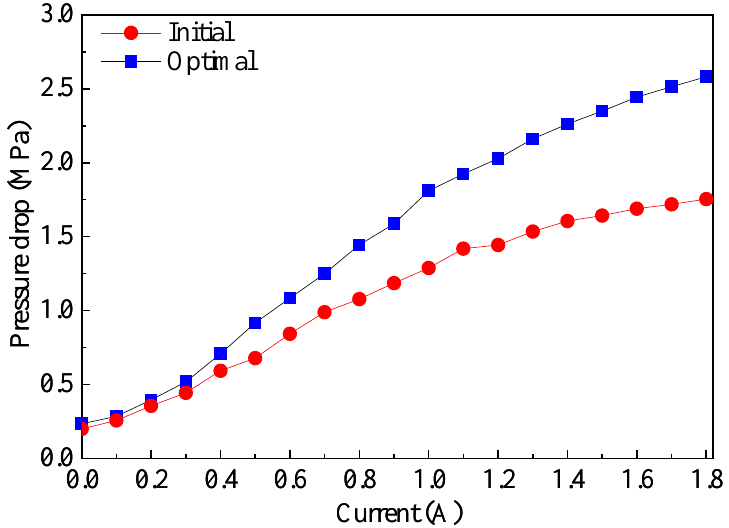
Figure 33. Pressure drop of initial and optimal radial flow MR valve controlled cylinder systems.